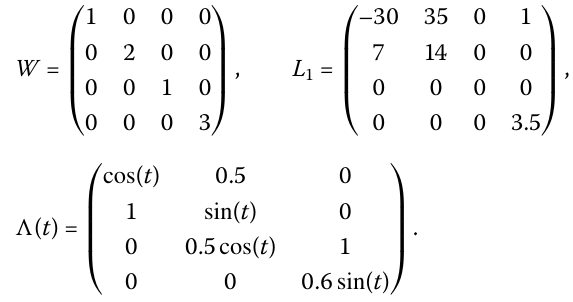
Figure 8 Attractors of the integer-order hyper-chaotic Chen